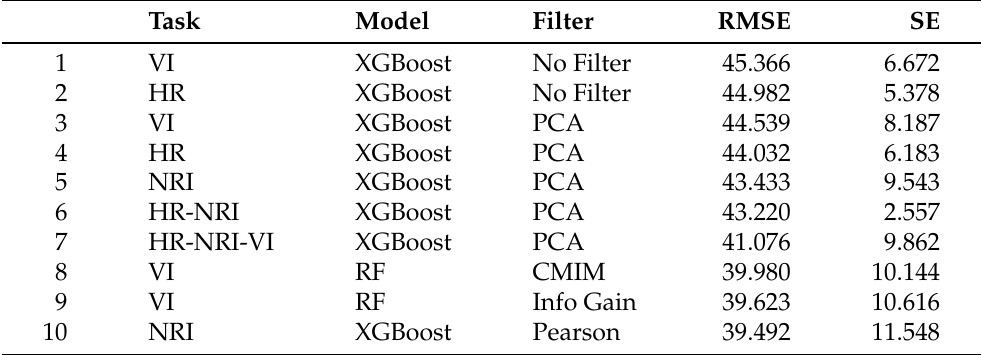
Table 6. Worst ten results among all learner–task–filter combinations, sorted in decreasing order of RMSE (p.p.) and their respective standard error